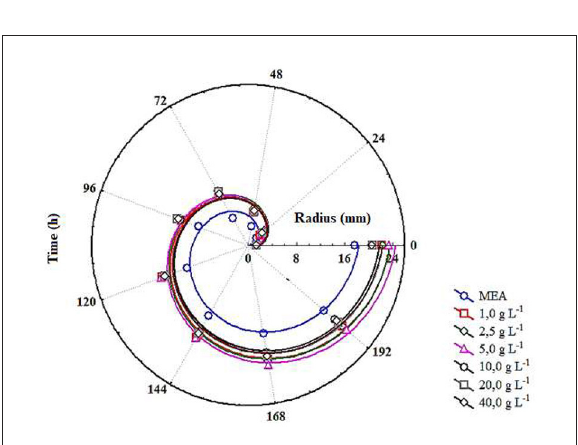
FIGURE1 Radial growth curves of the colonies of Monascus ruber CCT 3802 grown in different concentrations of maltose.